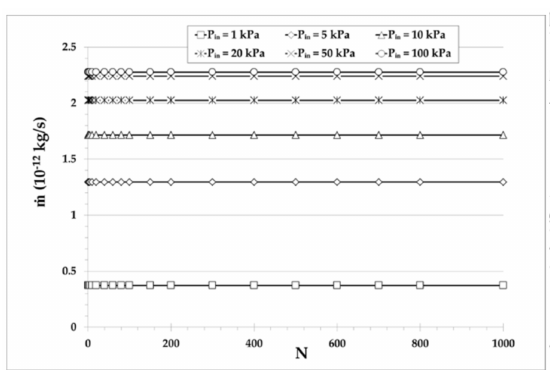
Figure 7. Maximum mass flow rate (corresponding to zero pressure di ff erence) of pump B with single narrow and wide microchannels of diameters d = 10 µ m and D = 100 µ m, respectively, in each stage, at various inlet pressures, versus the number of stages.